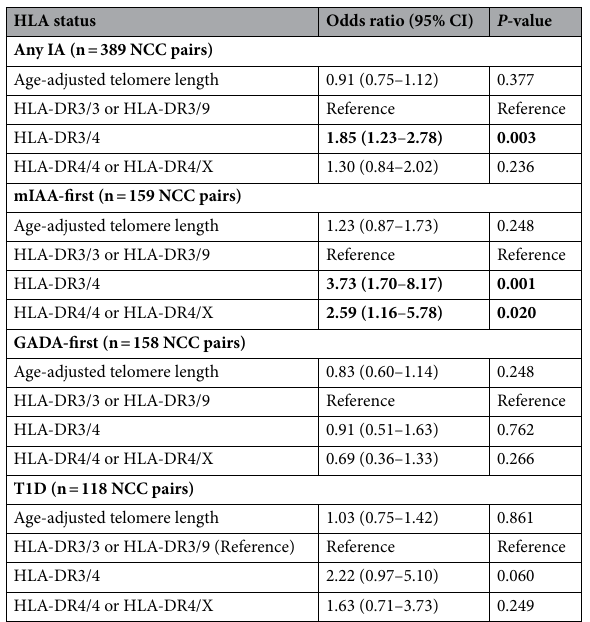
Table 3. Association between age-adjusted telomere length in subjects by the status of islet autoimmunity (IA, GADA-first or mIAA-first) and T1D in relation to HLA haplogenotypes. Complete data were available on 389 nested case–control (NCC) pairs for IA and on 118 matched pairs for T1D. Telomere length was adjusted for age when the sample was drawn. Significant values are in